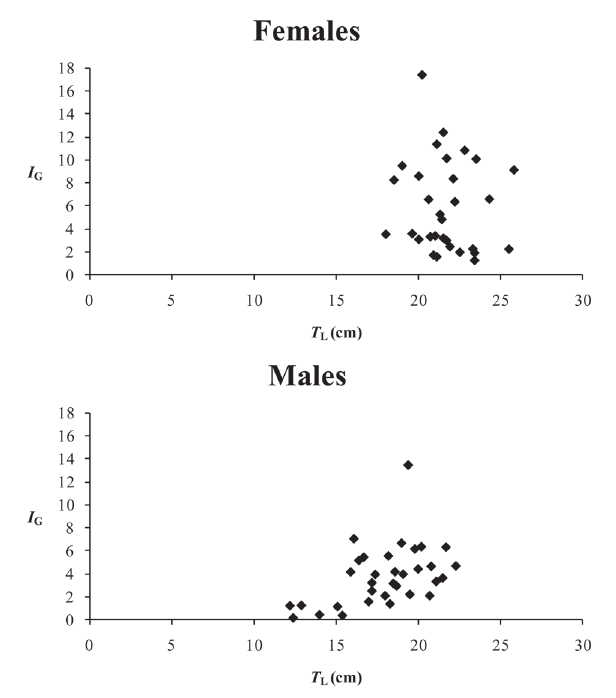
Fig. 9. Relationship between gonasosomatic index ( I size ( T ) of ripe females (n = 31) and males (n = 33) of Alphestes L afer during the reproductive peak (August up to September 2008,